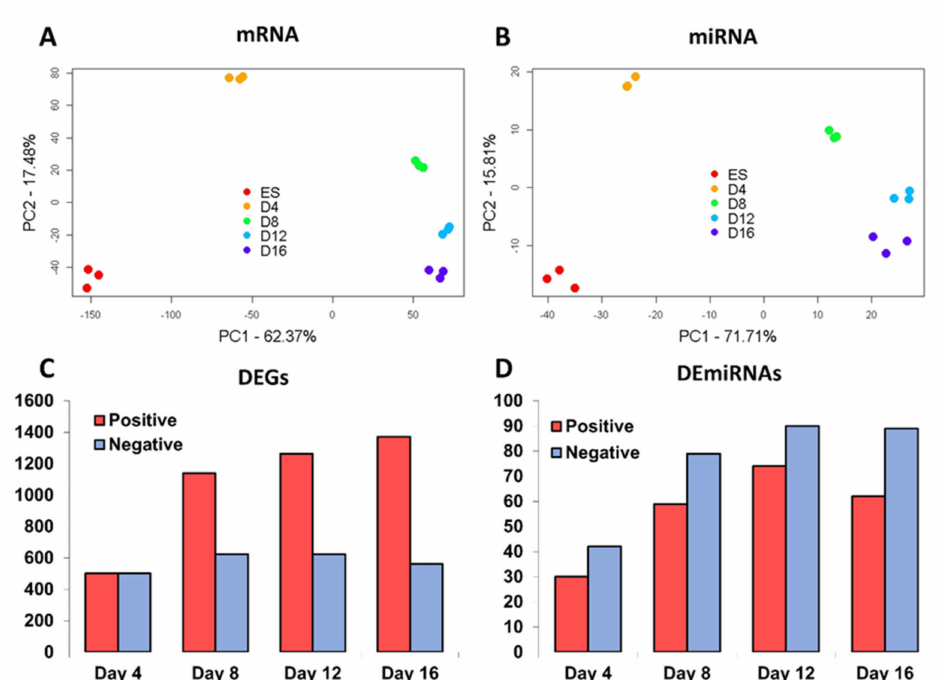
Figure 2. mRNA and miRNA profile analysis of in vitro ESCs differentiation. ( A , B ) Principal component analysis (PCA) of mRNA and miRNAs profiles. The two principal components (PC) capturing the largest variance for mRNA and miRNA are displayed. ( C , D ) Number of differentially expressed genes (DEGs) and miRNAs (DEmiRs) with positive or negative log2 fold changes in expression with day 0 as